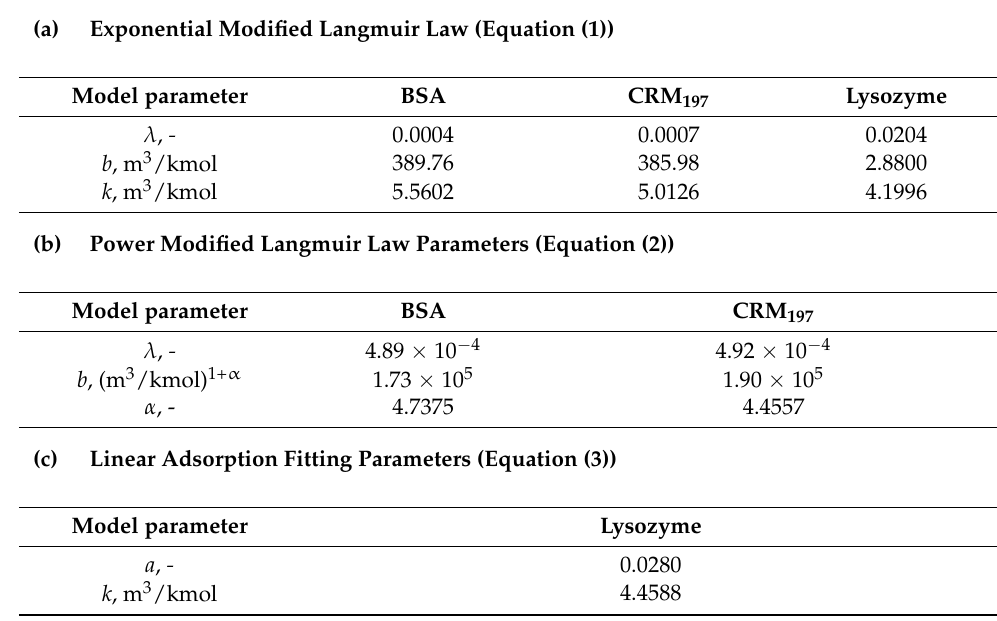
Table 3. Parameters obtained from the fitting of experimental data for the proteins